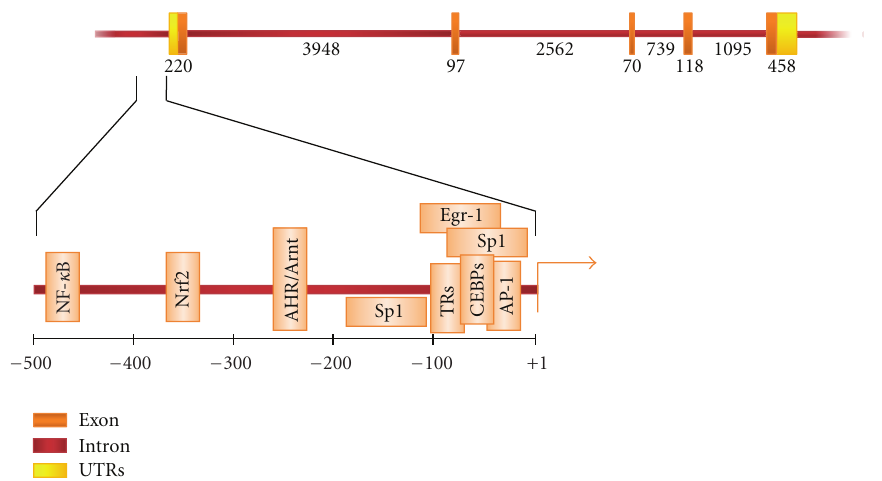
Figure 1: Genomic organization of human SOD1 gene. The size of exons and introns, in base pairs, is shown in association with each fragment. The 5 (cid:2) flanking region is expanded, and the transcription factors, interacting with the corresponding DNA regulatory elements, are shown at the bottom. The transcription start site is depicted as an arrow at position